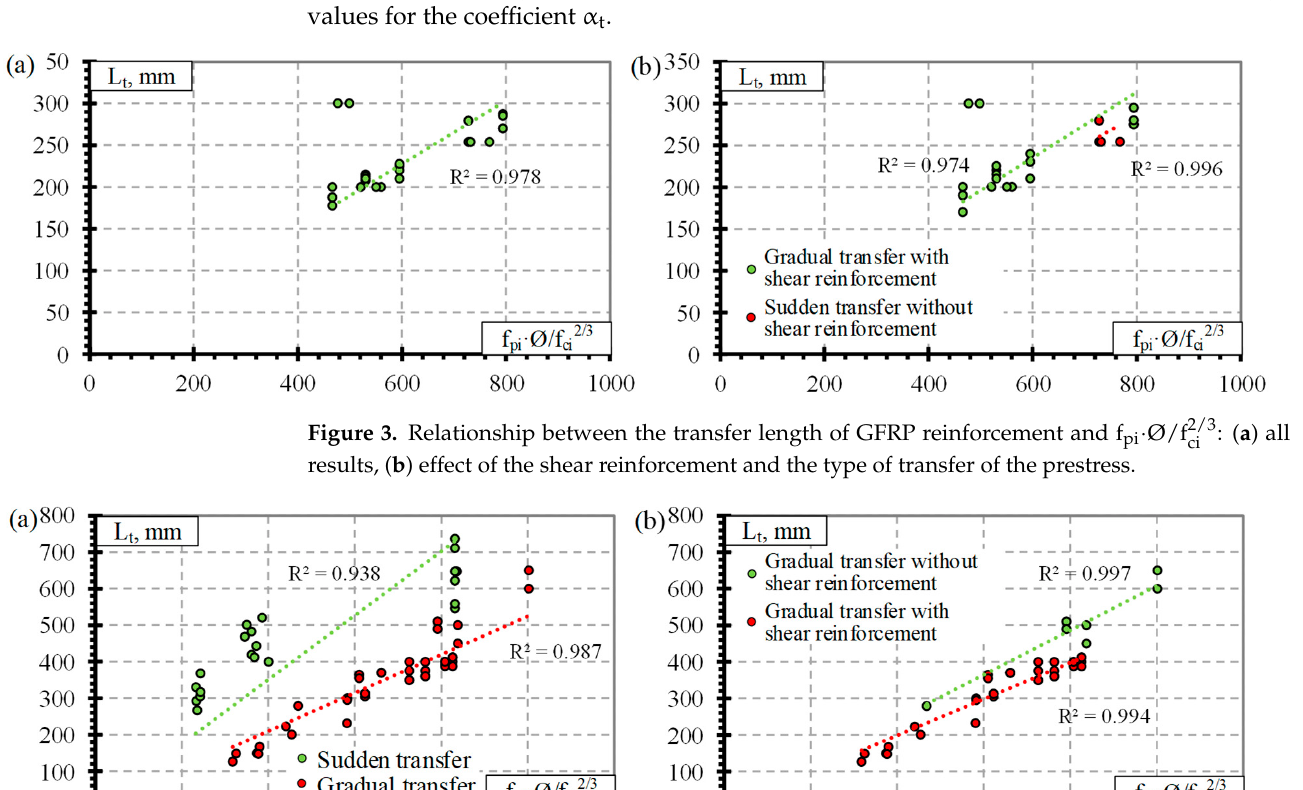
Figure 4. Relationship between the transfer length of CFCC strands and : ( a ) effect of types of transfer of prestressing, ( b ) effect of shear reinforcement.